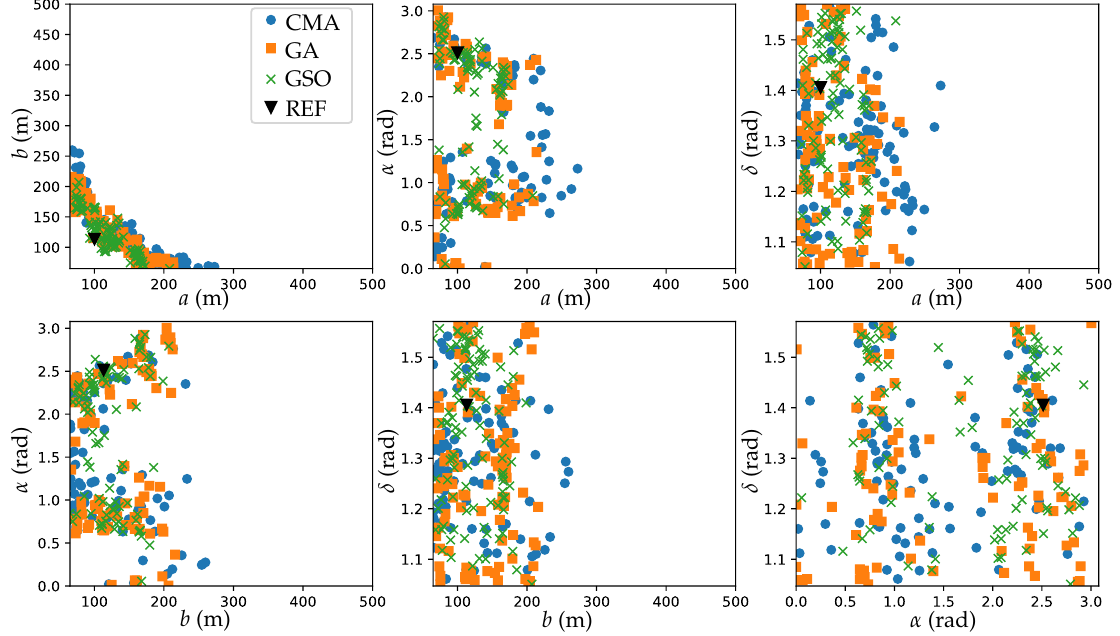
Figure 8. Optimal layout parameters found by the optimisers over the 100 runs and the reference layout parameters